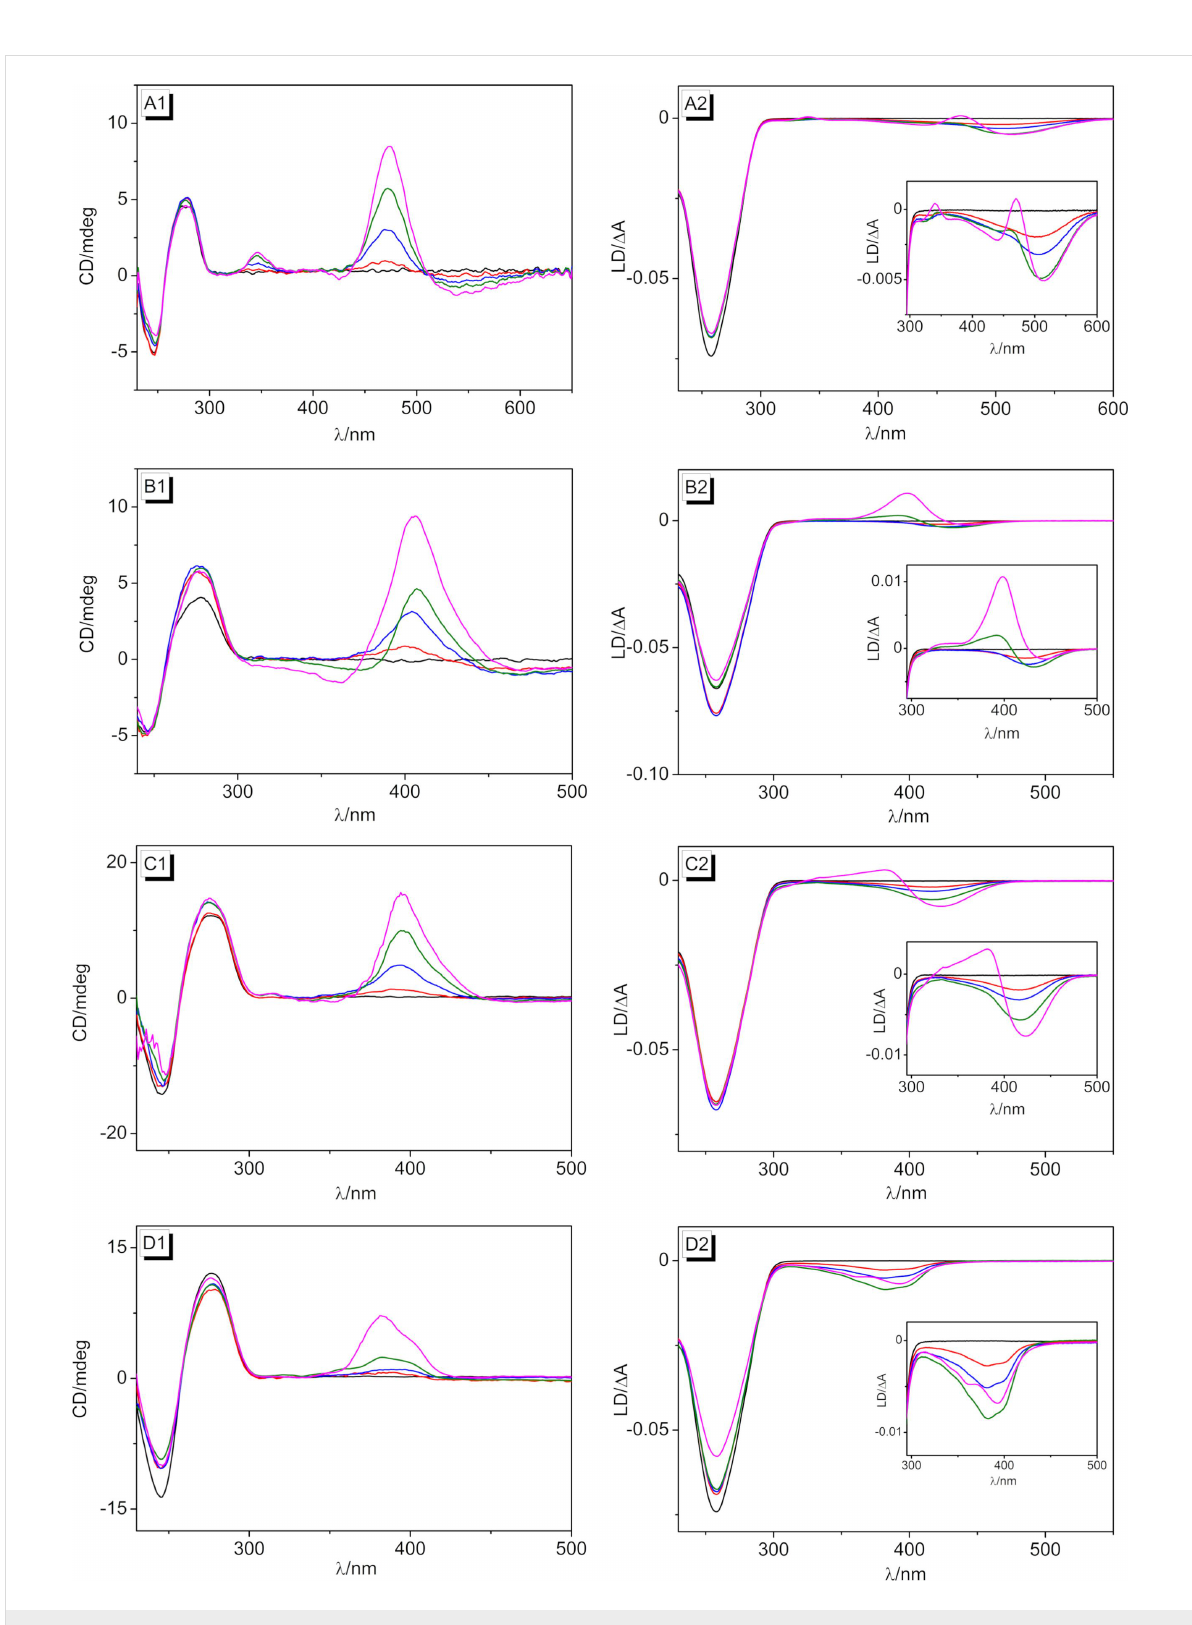
Figure 4: CD and LD spectra of the styryl derivatives 3a (A), 3b (B), 3c (C), and 3d (D) with ct DNA in BPE buffer [ c ct DNA = 20 µM (A1, B1), c ct DNA = 50 µM (C1, D1), and c ct DNA = 500 µM (A2–D2), with LDR = 0 (black), 0.5 (red), 1.0 (blue), 1.5 (green), and 2.0 (magenta), c ct DNA in base